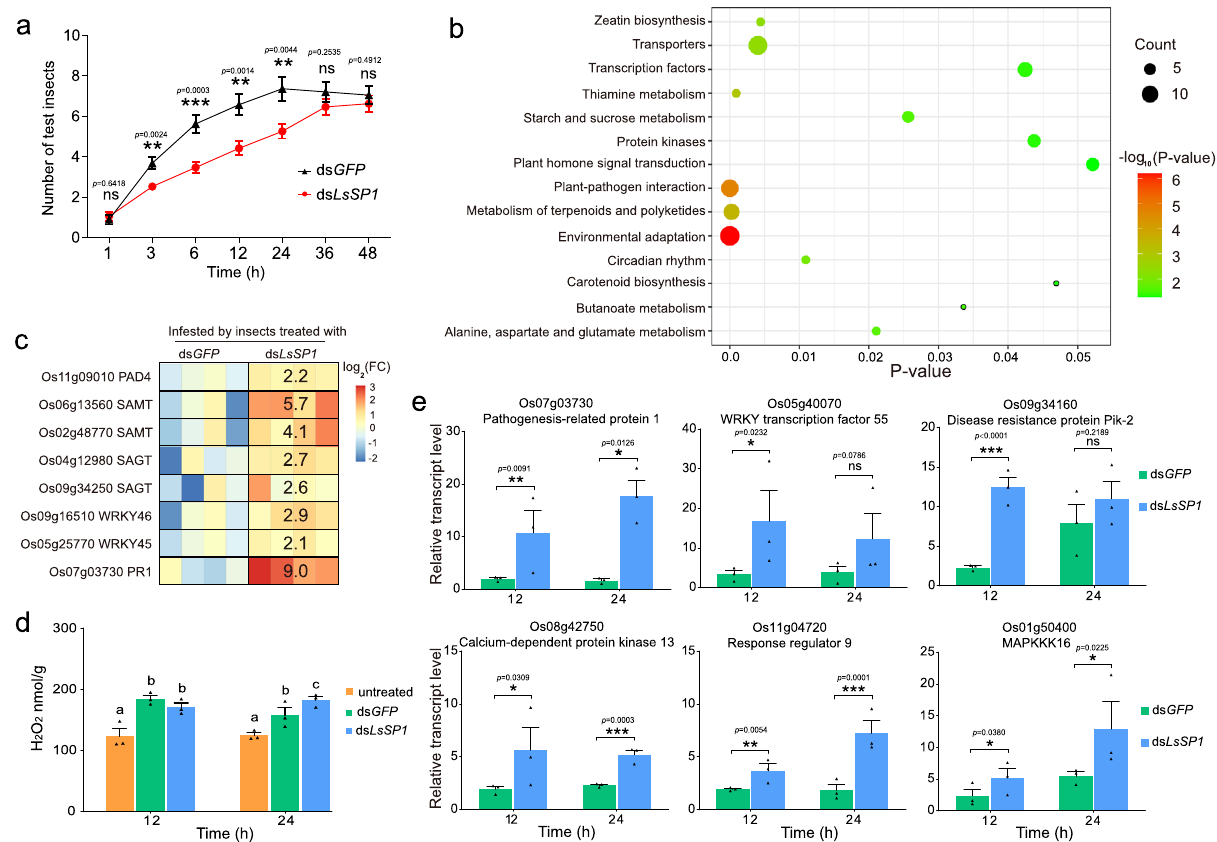
Fig. 4 | In fl uencesofdsRNA-treated Laodelphax striatellus onriceplants. a The attraction of rice plants infested by dsRNA-treated L. striatellus to nymphs in the two-choice equipment. Data are presented as mean values ±SEM ( n =19 indepen- dent biological replicates). P -values were determined by two-tailed unpaired Stu- dent ’ s t test. ** P <0.01; *** P <0.001; ns, not signi fi cant. b Kyoto Encyclopedia of Genes and Genomes (KEGG) pathway enrichment analysis of differentially expressed genes (DEGs).Enriched P -valueswerecalculated according to one-sided hypergeometric test using TBtools software 70 . c Upregulationof salicylicacid (SA)- relatedgenesinds LsSP1 -treated L.striatellus infestedplantscomparedwithds GFP - treated L.striatellus infestedones. d H 2 O 2 levelsintheuntreatedriceplantsandrice